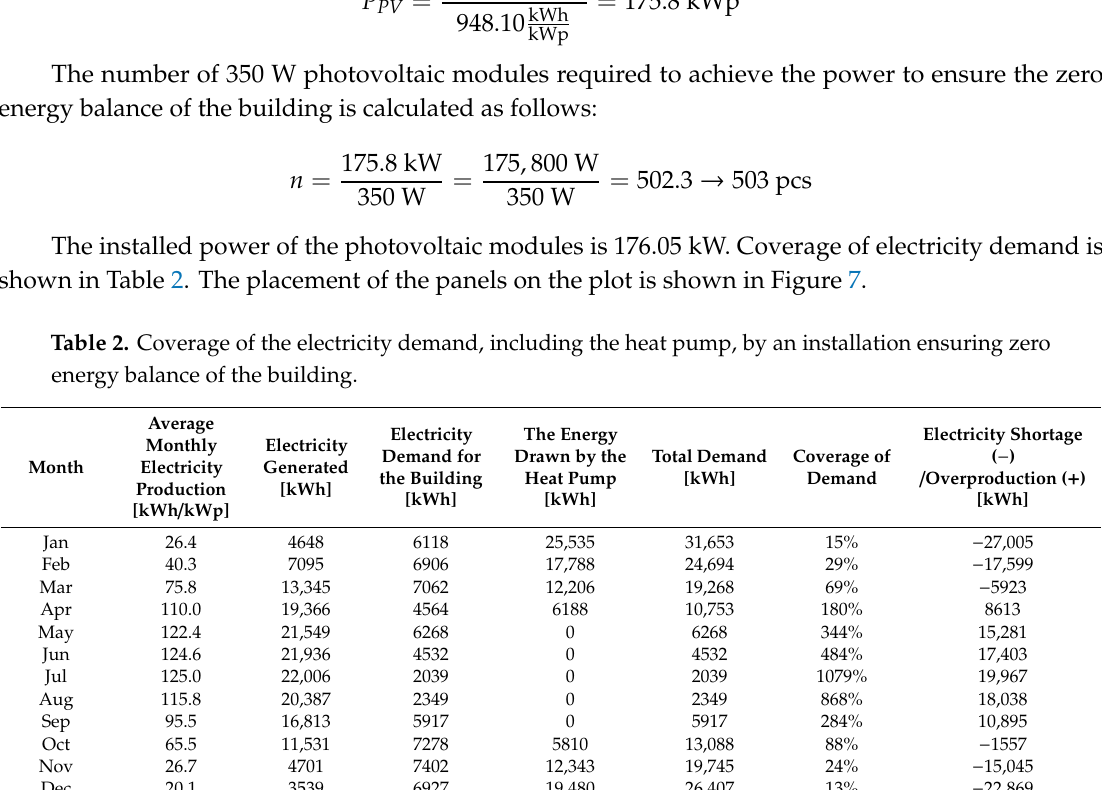
Table 2. Coverage of the electricity demand, including the heat pump, by an installation ensuring zero energy balance of the building.